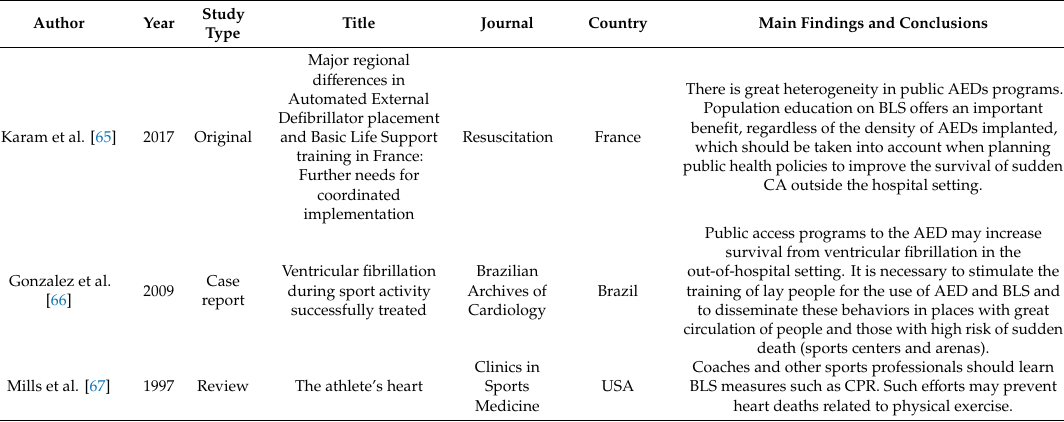
Table 5. Studies and their main conclusions related to basic life support (BLS) in